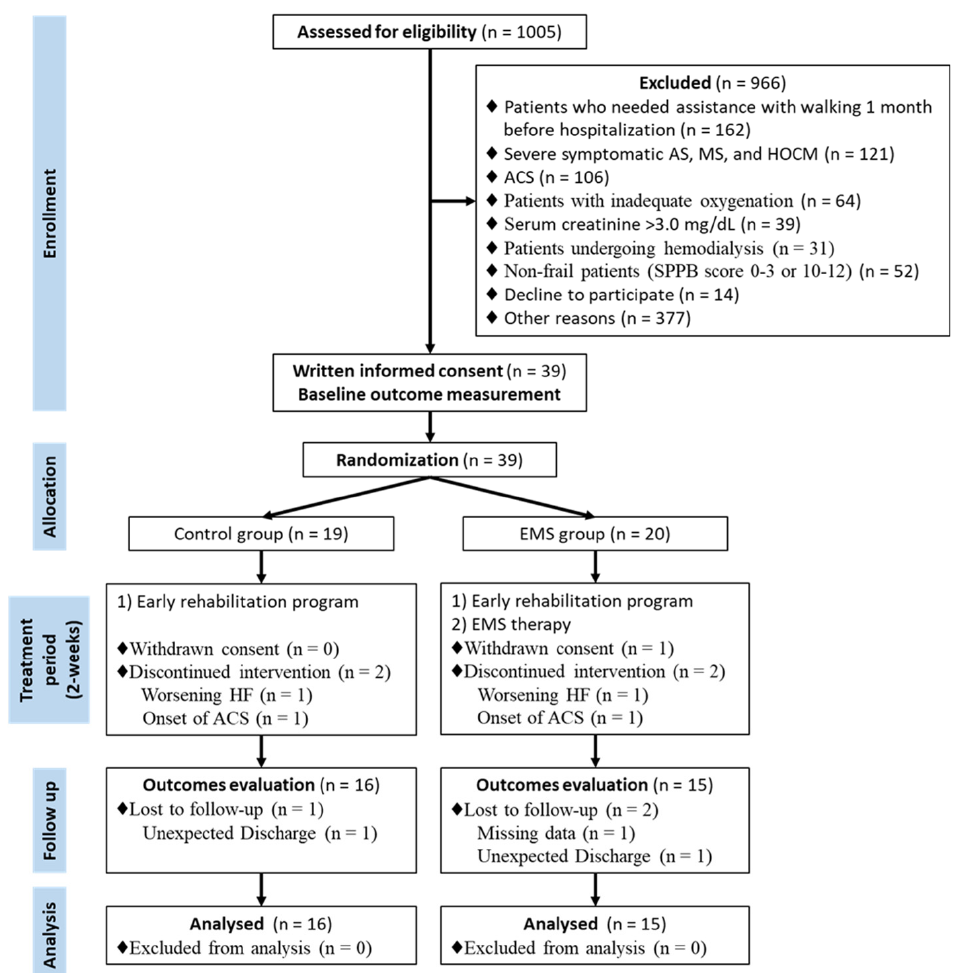
Figure 2. Study flow diagram. ACS, acute coronary syndrome; AS, aortic stenosis; EMS, electrical muscle stimulation; HF, heart failure; HOCM, hypertrophic obstructive cardiomyopathy; MS, mitral stenosis; SPPB, short physical performance battery.